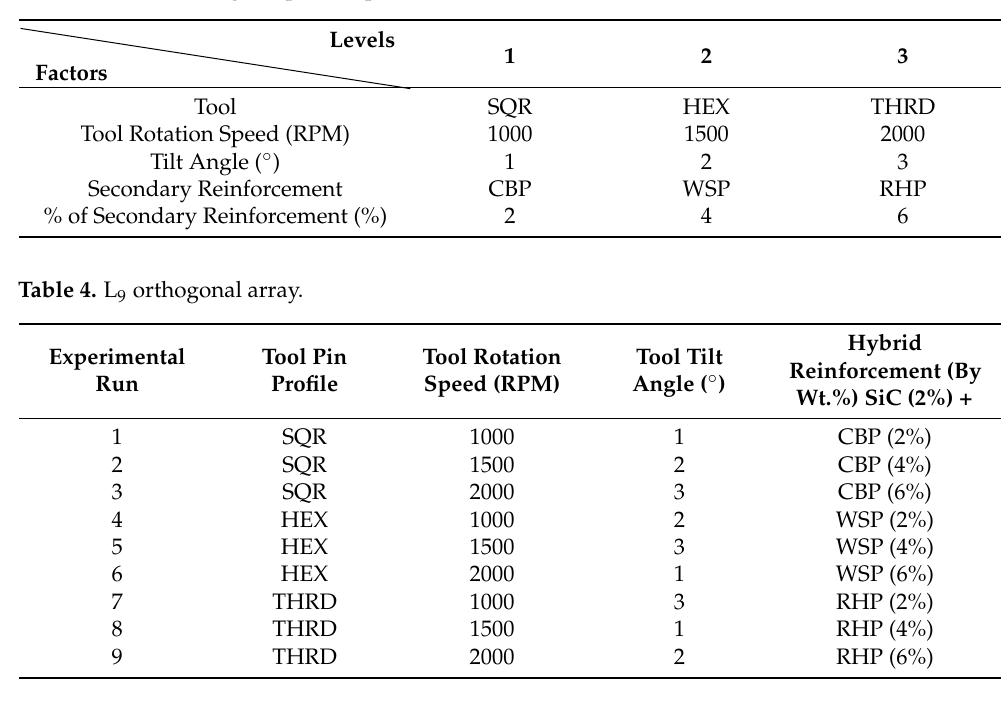
Figure 2. Different tool pin profile; ( a ) hexagonal, ( b ) square, ( c ) threaded. Table 3. Level of design of process parameters.